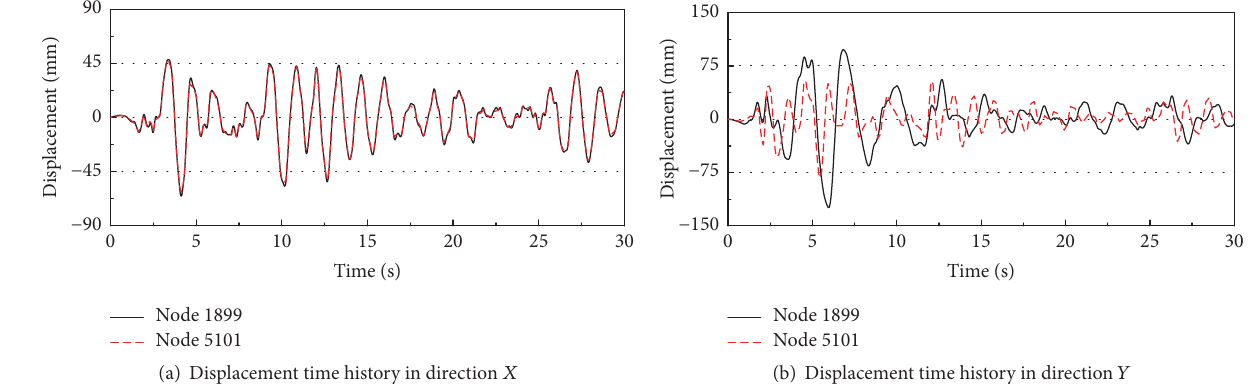
Figure 16: Displacement of node 1899/5101 under El-Centro of rare